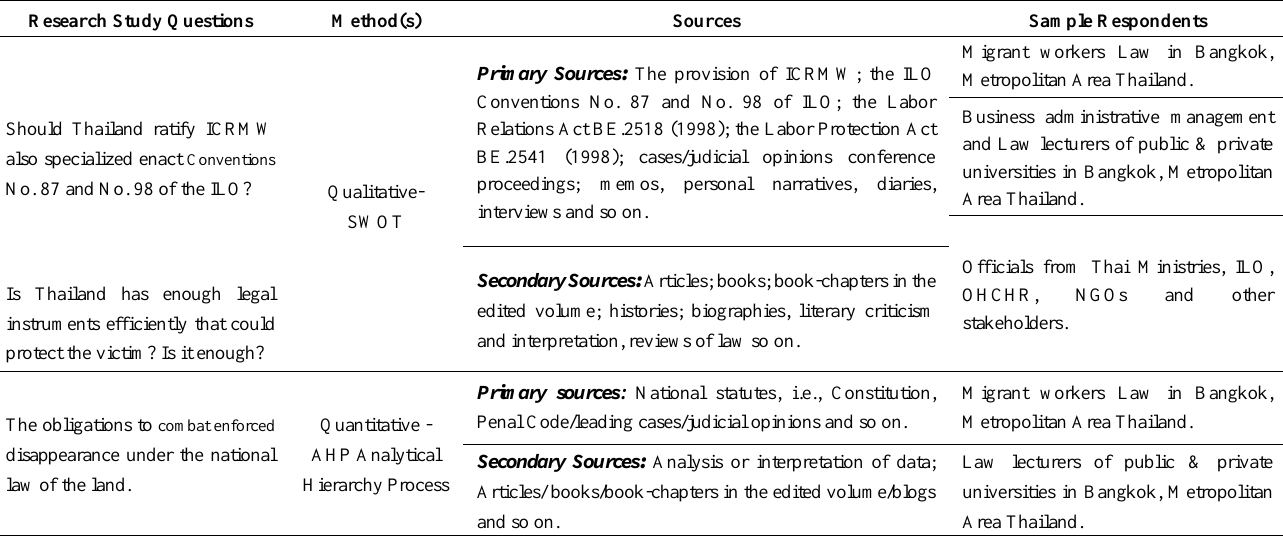
Table 3. Research methodological approach towards this research